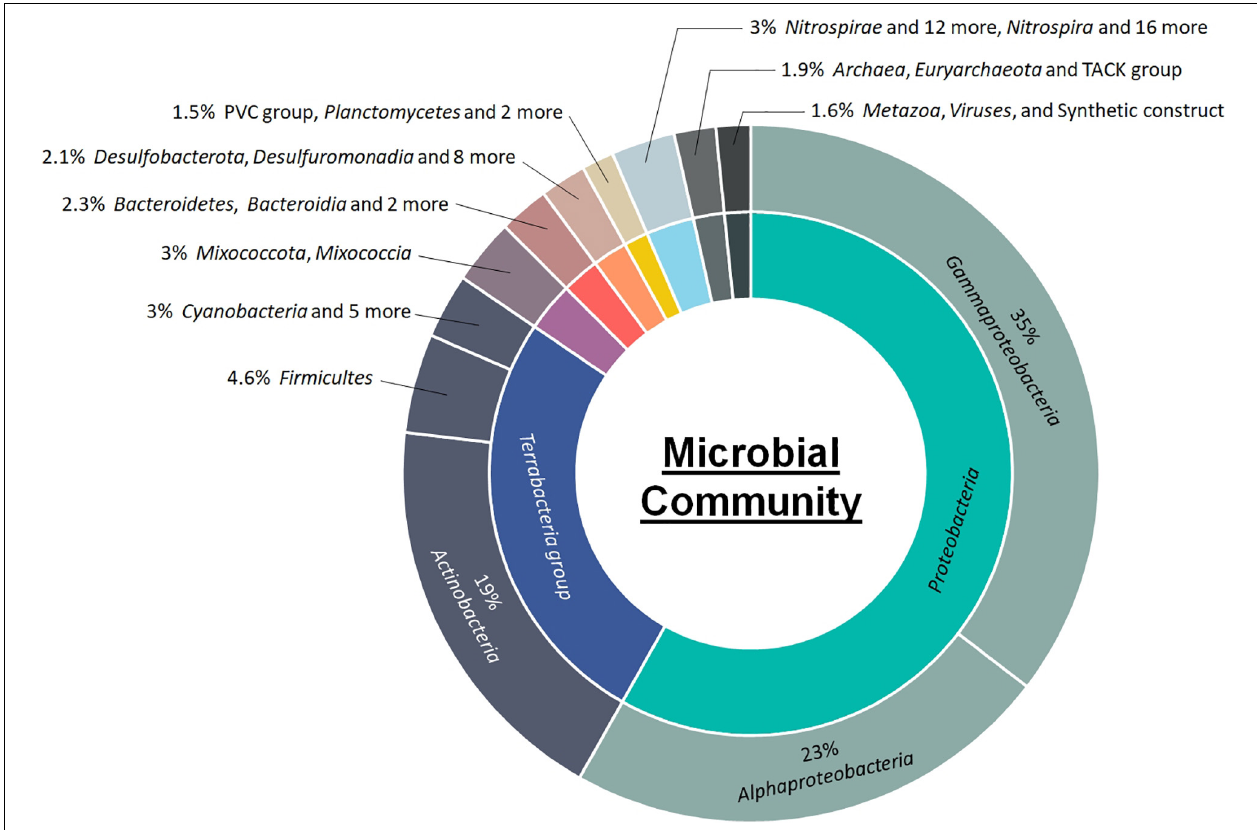
FIGURE 1 | Class-level microbial community composition and relative abundance in activated sludge of landfill leachate.